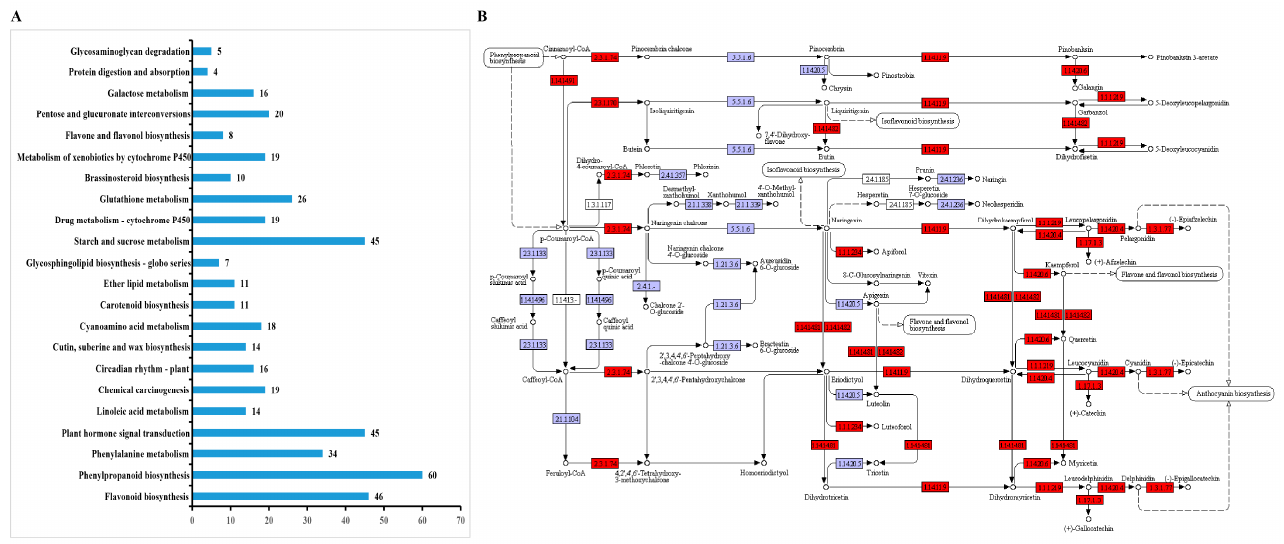
Figure 7. Kyoto Encyclopedia of Genes and Genomes (KEGG) pathway analysis of Larix kaempferi transcriptome sequencing data. ( A ) Overview of the KEGG analysis results ( p < 0.05). ( B ) Genes with considerable marked changes ( p < 0.05) in the expression of flavonoid biosynthesis pathways, in the LaMIR166a -overexpressing lines.